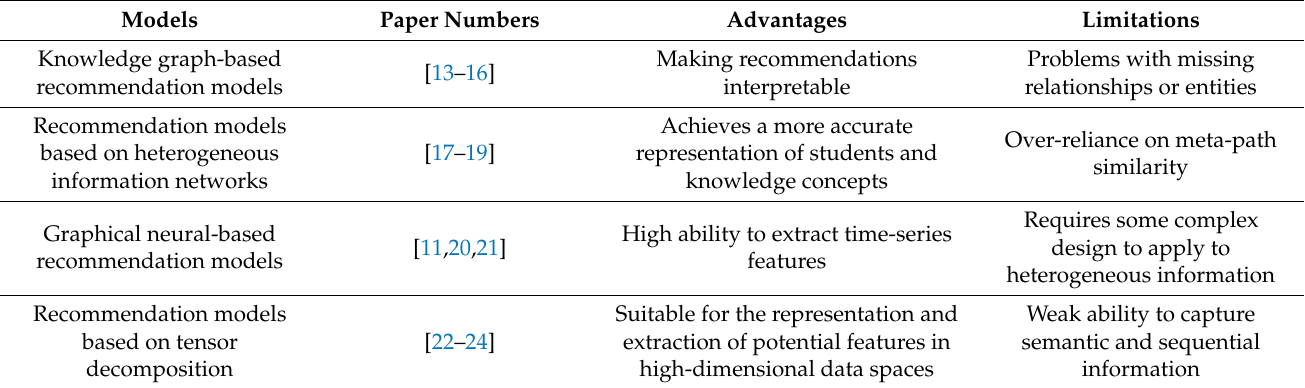
Table 1. Summary of relevant research